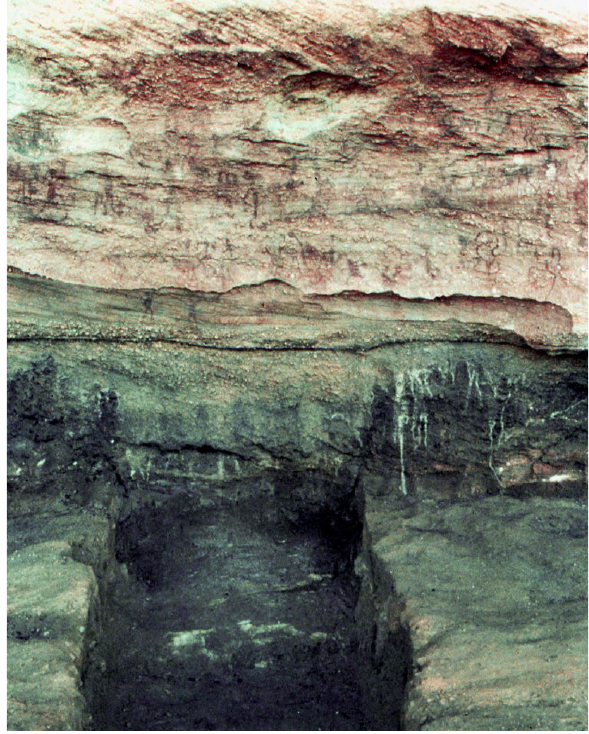
Figure 7. Pictograms of Perna I rockshelter, São Raimundo Nonato, Piauí, Brazil, at least 9500 years